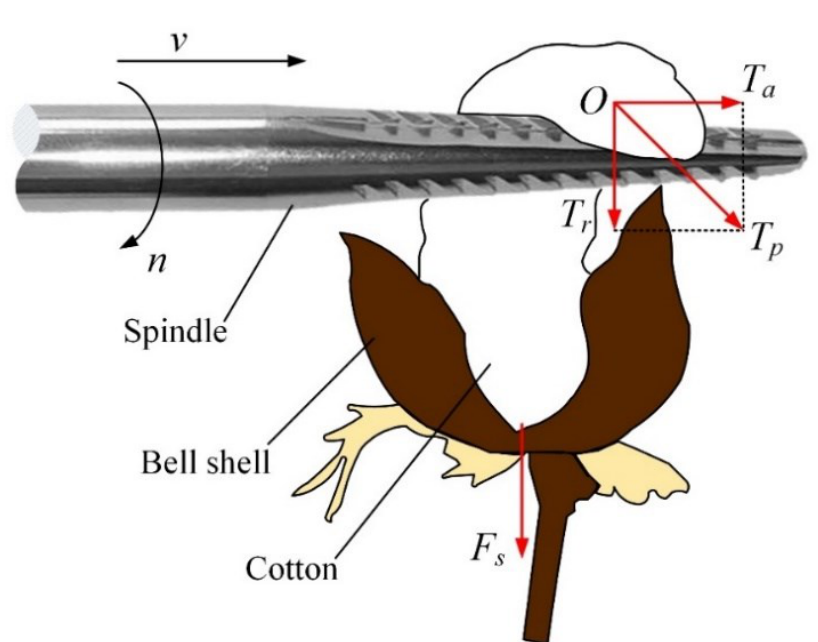
Figure 2. Mechanical model of the spindle-picking process: v, feed speed; n, spindle speed; T p , picking force; T a , axial picking force; T r , radial picking force and F s , picking resistance. Simultaneously, cotton will be subjected to picking resistance F s generated by the boll shell when picking cotton from the spindle due to the biological connection force between cotton and boll shell. To ensure the effective separation of cotton and boll shell, the following conditions must be met